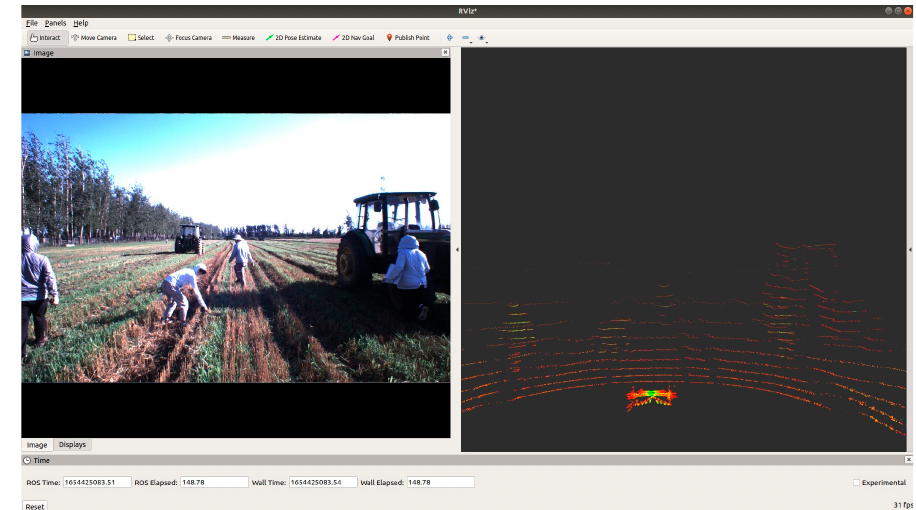
Figure 2. RVIZ visualization of the collected data.